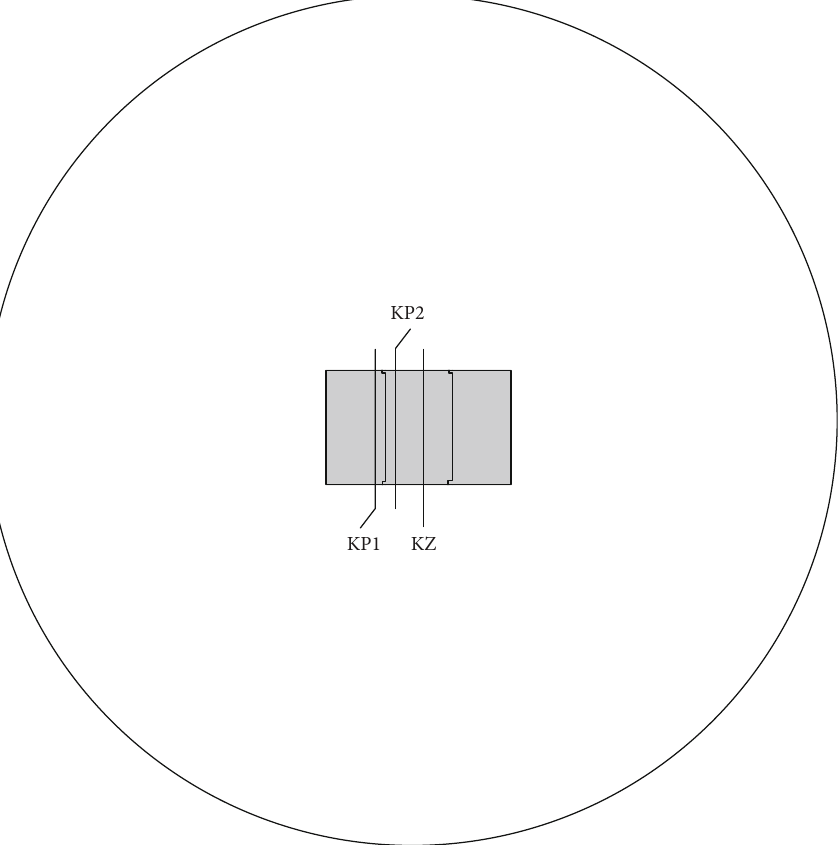
Figure 3: Monitoring point section